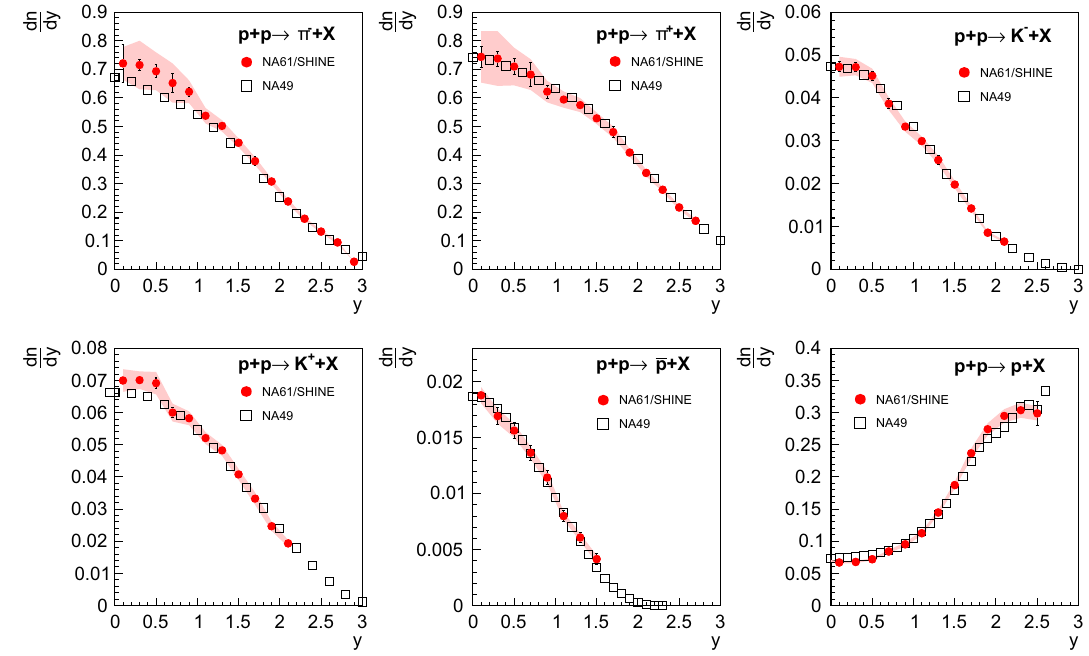
Fig. 20 Comparison of rapidity distributions of pions, kaons and protons produced in inelastic p + p interactions at 158 GeV / c . The plotted NA49 results were published without uncertainties [11–13]. NA61/SHINE systematic uncertainties are shown as shaded red bands